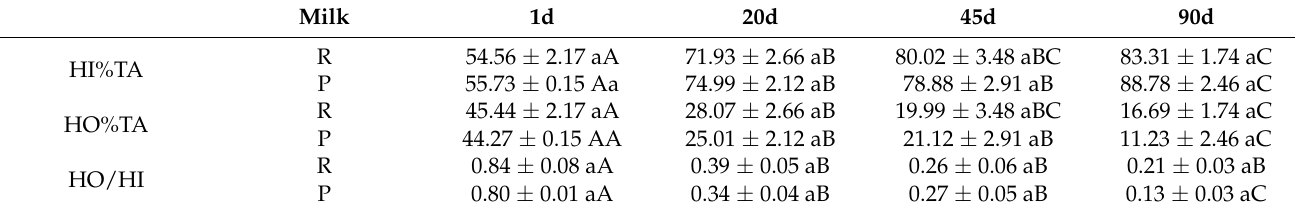
Table 5. Hydrophobic (HO) and hydrophilic (HI) peptides (%TA) in the water-soluble fraction of hard Xinotyri cheese made from raw (R) or pasteurized milk (P), during ripening and storage (i) .